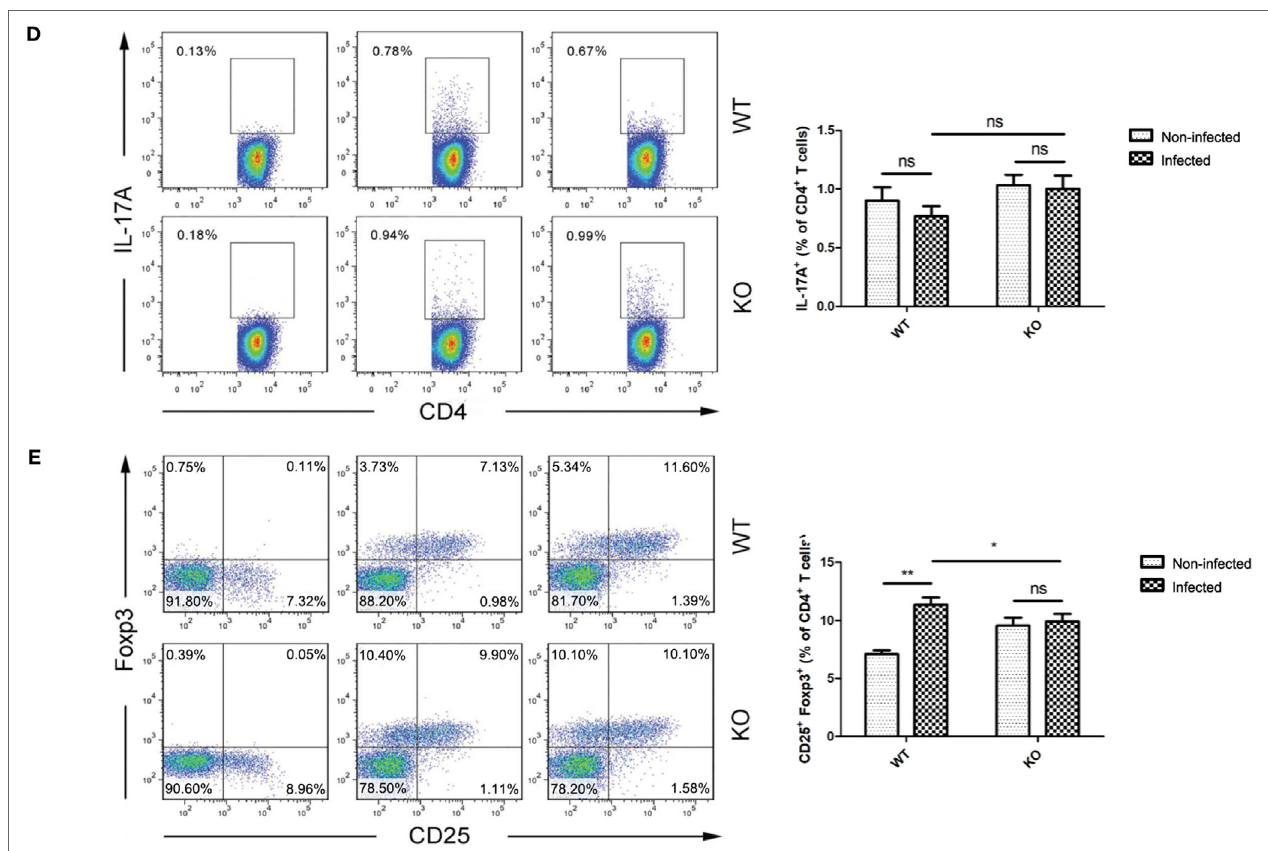
FigUre 4 | Programmed death 1 (PD-1) knockout abated Trichinella spiralis -induced Th1/17 inhibition and Th2/regulatory T cell (Treg) enhancement. Single-cell suspensions of spleens from wild-type (WT) and PD-1 − / − mice (KO) infected with or without T. spiralis were prepared. (a) Cytokine profiles secreted by